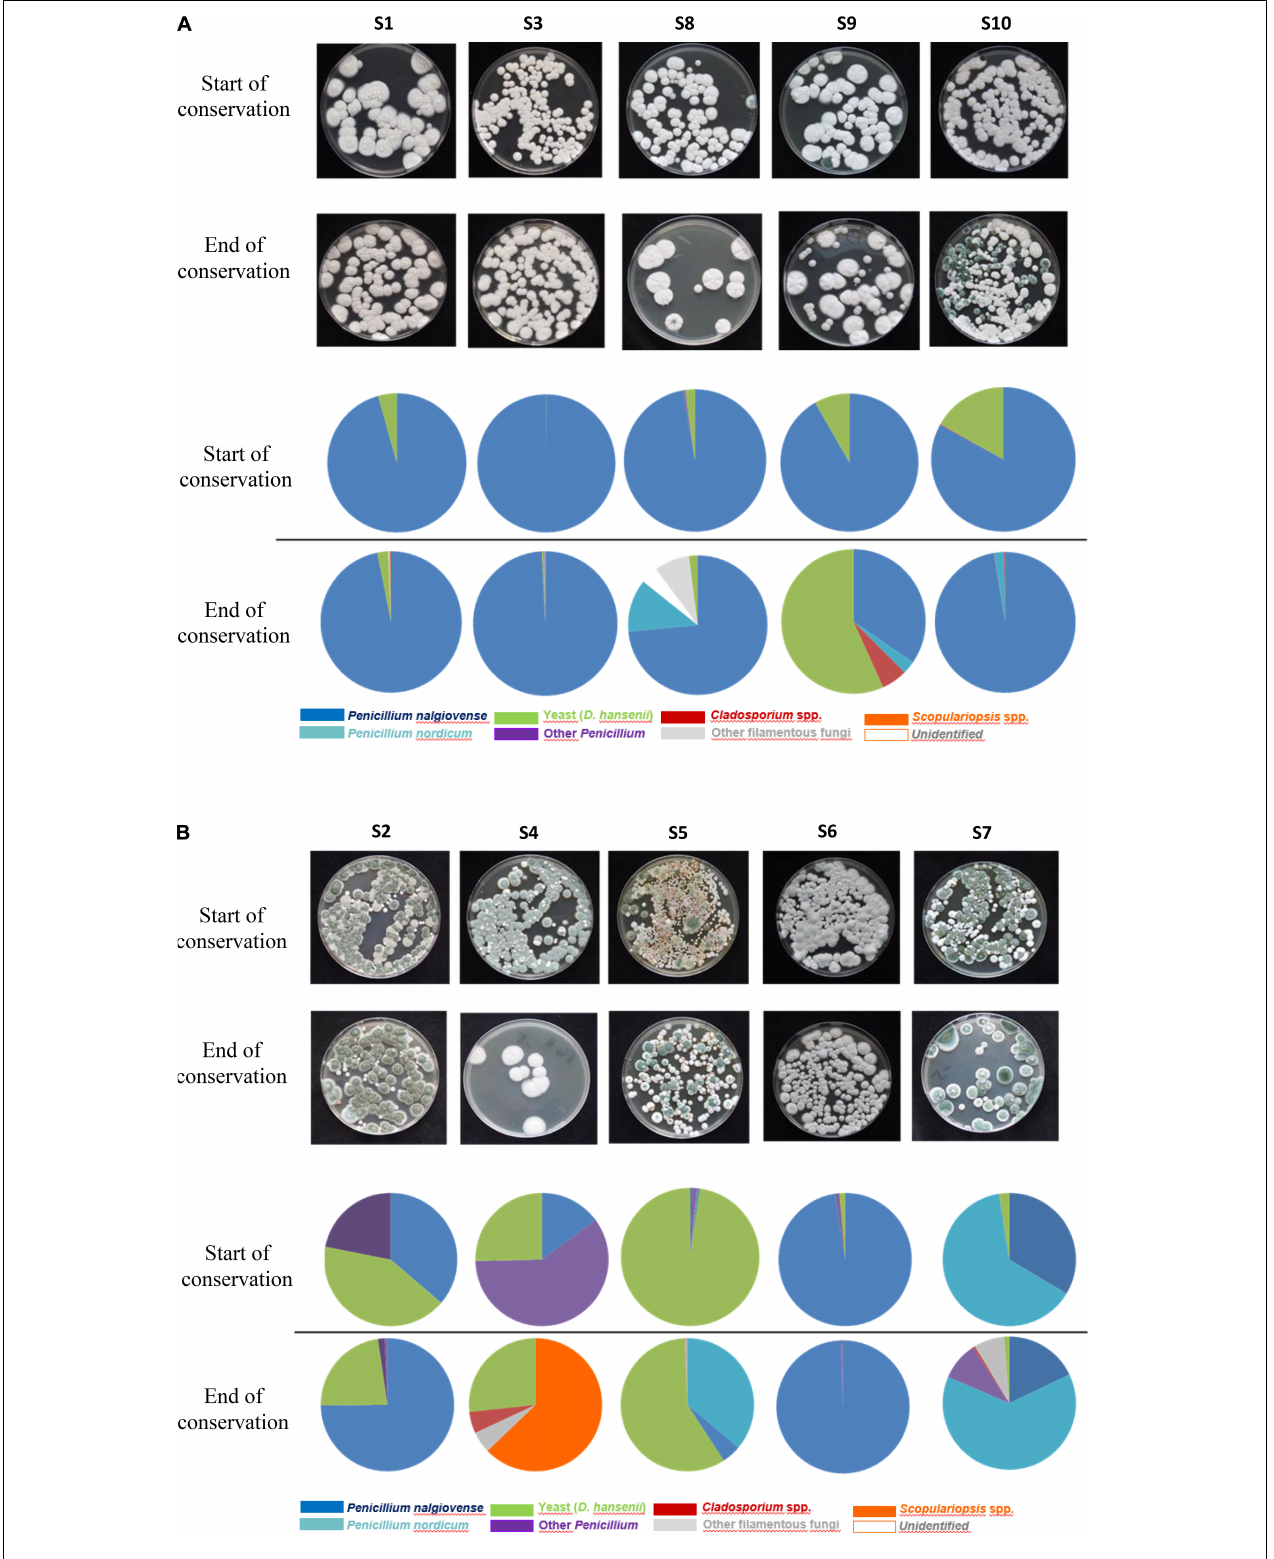
FIGURE 1 | (A) Fungal diversity observed on at the start and end of conservation for the five dry fermented sausages voluntarily surface-inoculated with molds. (B) Fungal diversity observed at the start and end of conservation for the five dry fermented sausages naturally surface-inoculated with molds.